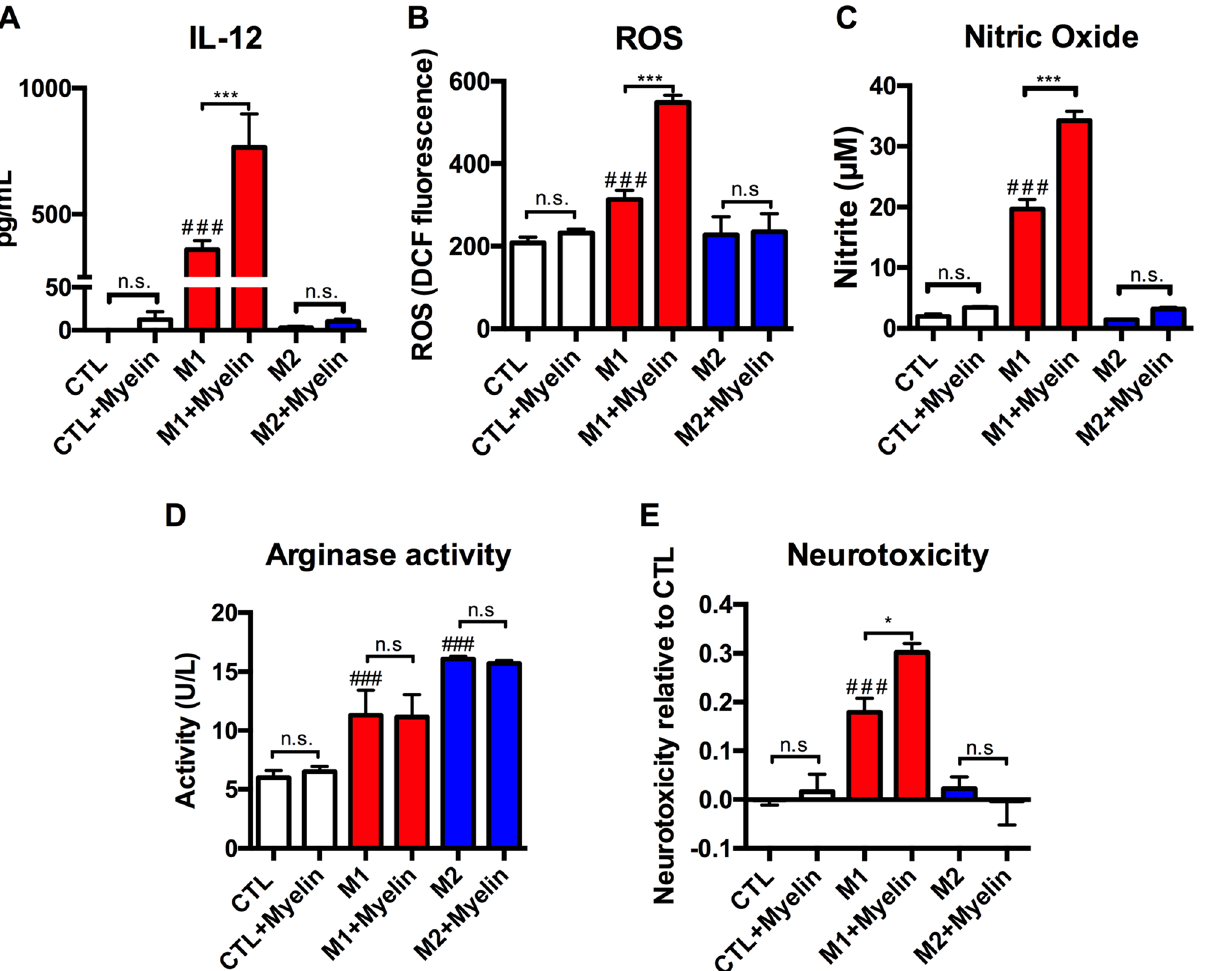
Figure 2. Myelin potentiates pro-inflammatory macrophage activation in vitro. Bone marrow derived macrophages (BMDMs) were utilized to determine the function outcomes resulting from myelin debris application under three distinct activation states: M1 (IFN-γ and LPS), M2 (IL-4), or CTL (media, i.e. unstimulated). ( A ) Myelin stimulation significantly increased pro-inflammatory IL-12 cytokine levels relative to M1 alone (***p < 0.001), however myelin did not increase IL-12 in CTL or M2 treated cells. M1 stimulations had increased IL-12 relative to CTL or M2 ( ### p < 0.001). ( B ) Following the stimulation BMDMs were washed and treated with 2 µM H2DCFDA for 25 min. Myelin stimulation increased ROS relative to M1 alone (***p < 0.001), however myelin did not increase ROS in CTL or M2 treated cells. M1